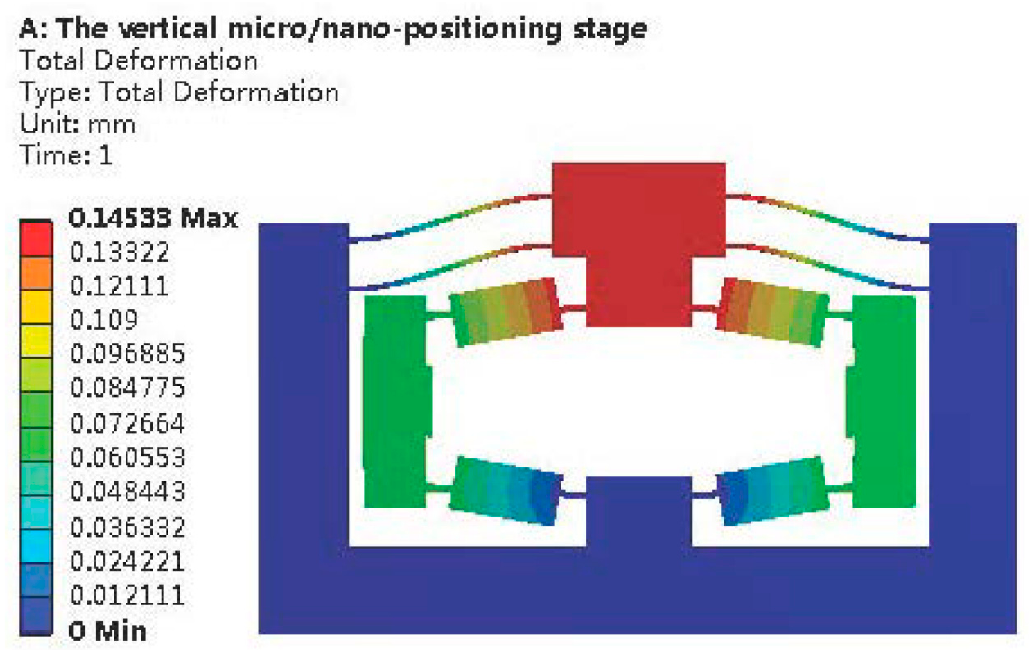
Figure 13. The deformation results of the vertical micro/nano-positioning mechanism.